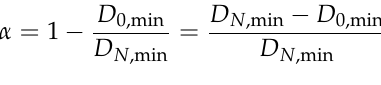
D under freeze-thaw cycles. ( a ) max